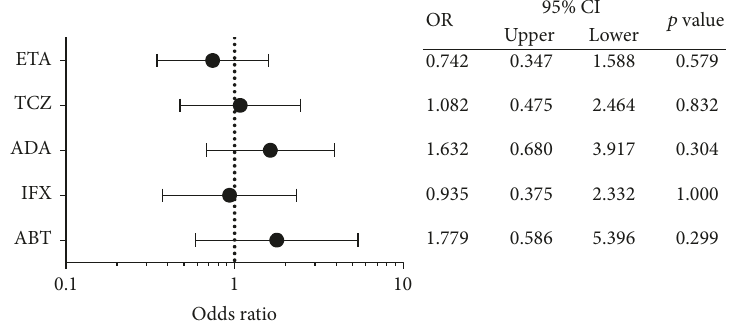
Figure 2: Odds ratio for hospitalized infection according to di ff erent biological disease-modifying antirheumatic drug. ETA: etanercept; TCZ: tocilizumab; ADA: adalimumab; IFX: in fl iximab; ABT: abatacept.